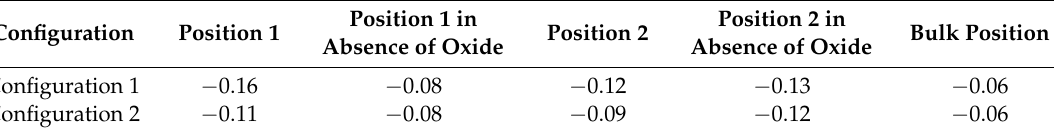
Table 2. Segregation energy (in eV/at) for the formation of copper aggregates in an aluminum slab covered by an oxide film according to the position and configuration of the doped layers. See Figure 7 for the illustration of the different configurations. Position 2 in Position 1 in Bulk Position Position 2 Configuration Position 1 Absence of Oxide Absence of Oxide Configuration 1 Configuration